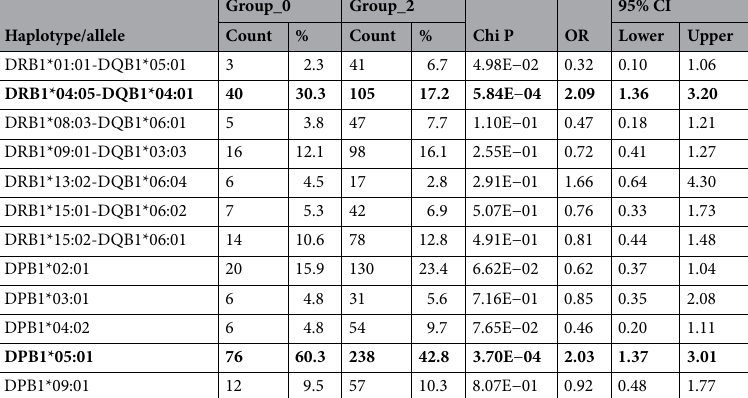
Table 1. Associations of HLA class II alleles with a response to the Heptavax-II vaccine in a comparison between poor-responders (Group_0) and high-responders (Group_2). The estimated DRB1-DQB1 haplotype frequencies over 5.0% and DPB1 allele frequencies over 5.0% in high-responders (Group_2) are shown. The result of DRB1*13:02-DQB1*06:04 was added for discussion in the paper. The total numbers of poor- responders and high-responders were 63 and 278, respectively, for the DPB1 allele and 66 and 305, respectively, for the DRB1-DQB1 haplotype. Significance level (α) in HLA association analysis was determined by the sorting test, with P < 0.00293 for the DRB1-DQB1 haplotype and P < 0.00980 for the DPB1 allele. P values and odds ratios (OR) were calculated by Pearson’s chi-square test for presence vs. absence of each allele. P values and OR that were statistically significant after correction are indicated in